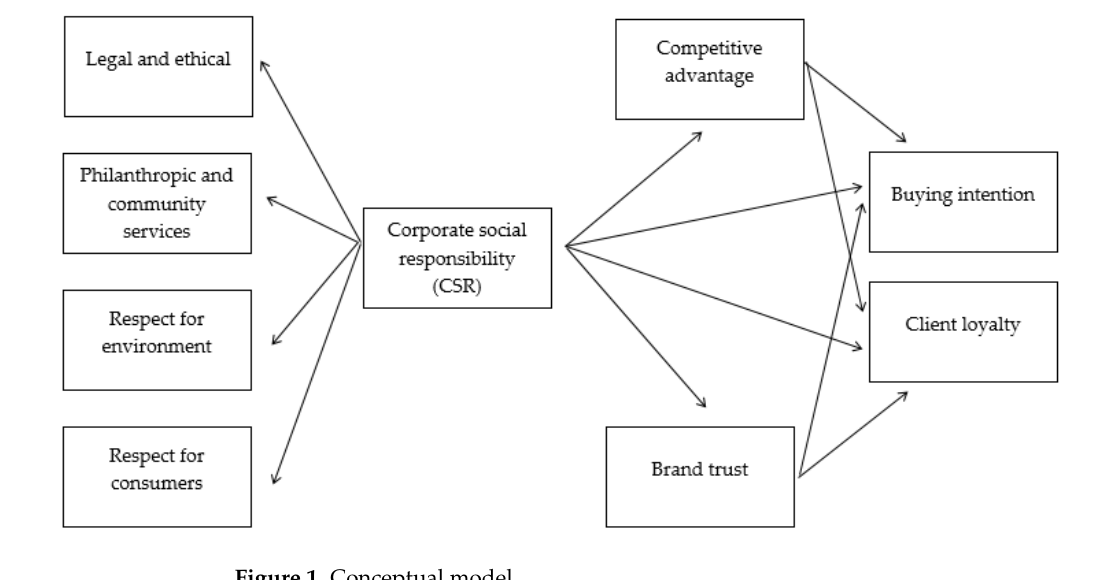
Figure 1. Conceptual model.